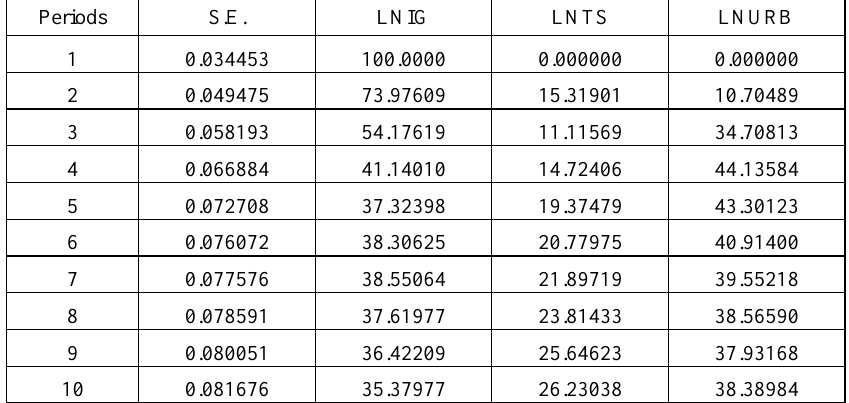
Table 3. Contribution to the variance of the urban-rural income gap (lnIG).